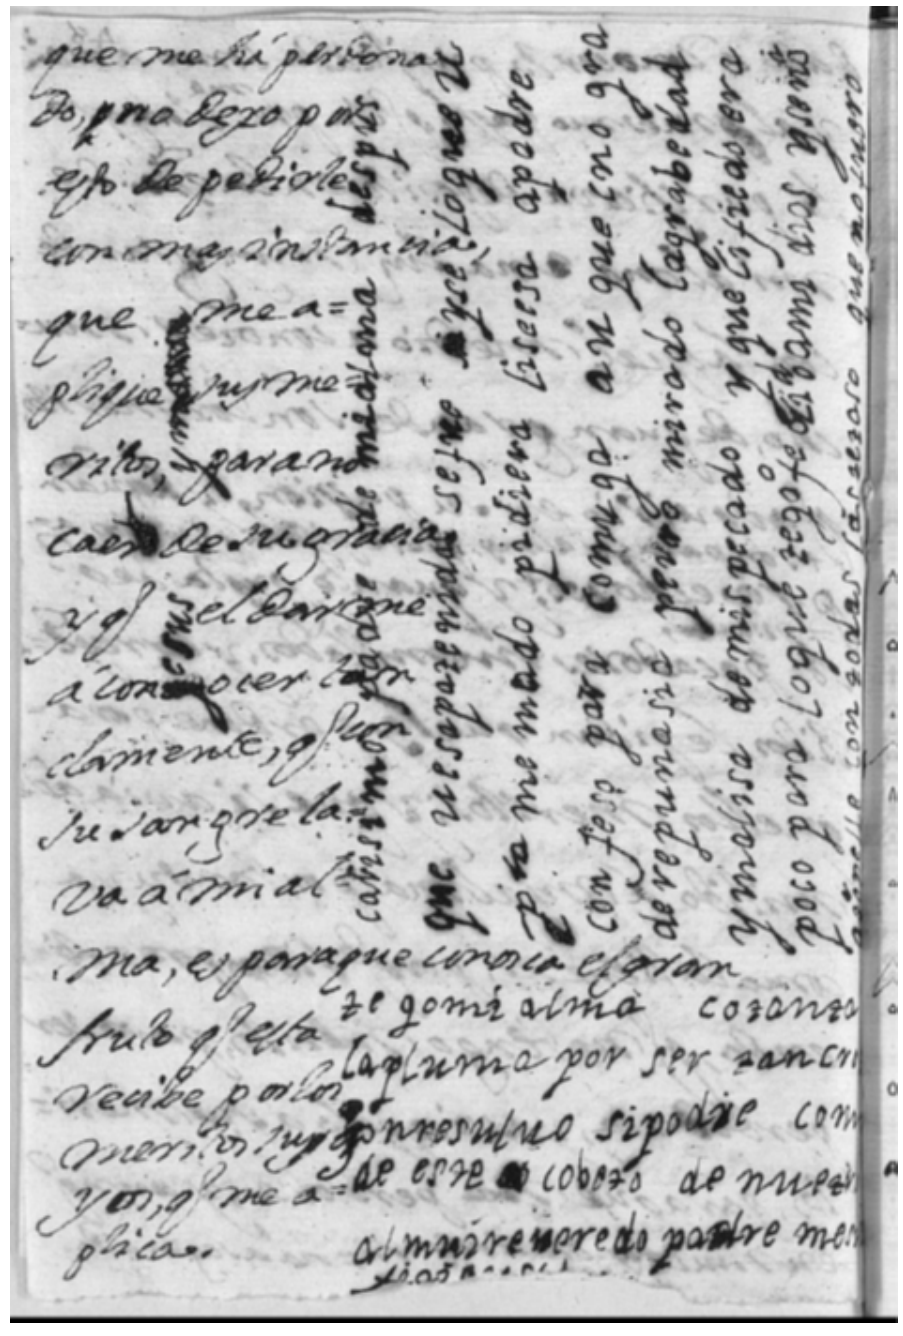
Figure 2. Folio frome the Vida of María de Ortola.